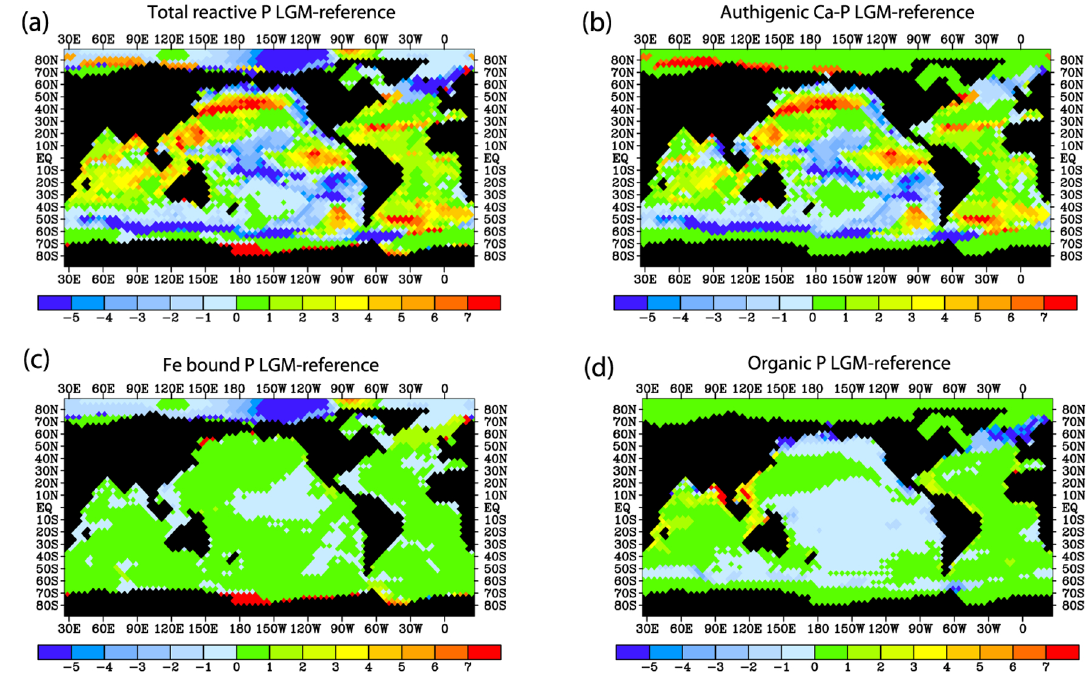
Fig. 7. Sedimentary P anomalies (averaged over the sediment-bioturbated layer) in the LGM simulation relative to the reference run for (a) total reactive P, (b) authigenic Ca-P, (c) Fe bound P, and (d) particulate organic P. Units in µmolPg − 1 .